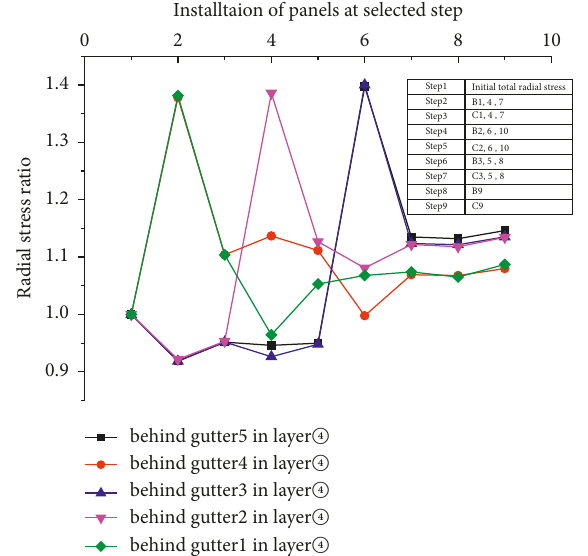
Figure 17: Increase and decrease of lateral stress behind existing panel at layer ④ during the whole process of panel